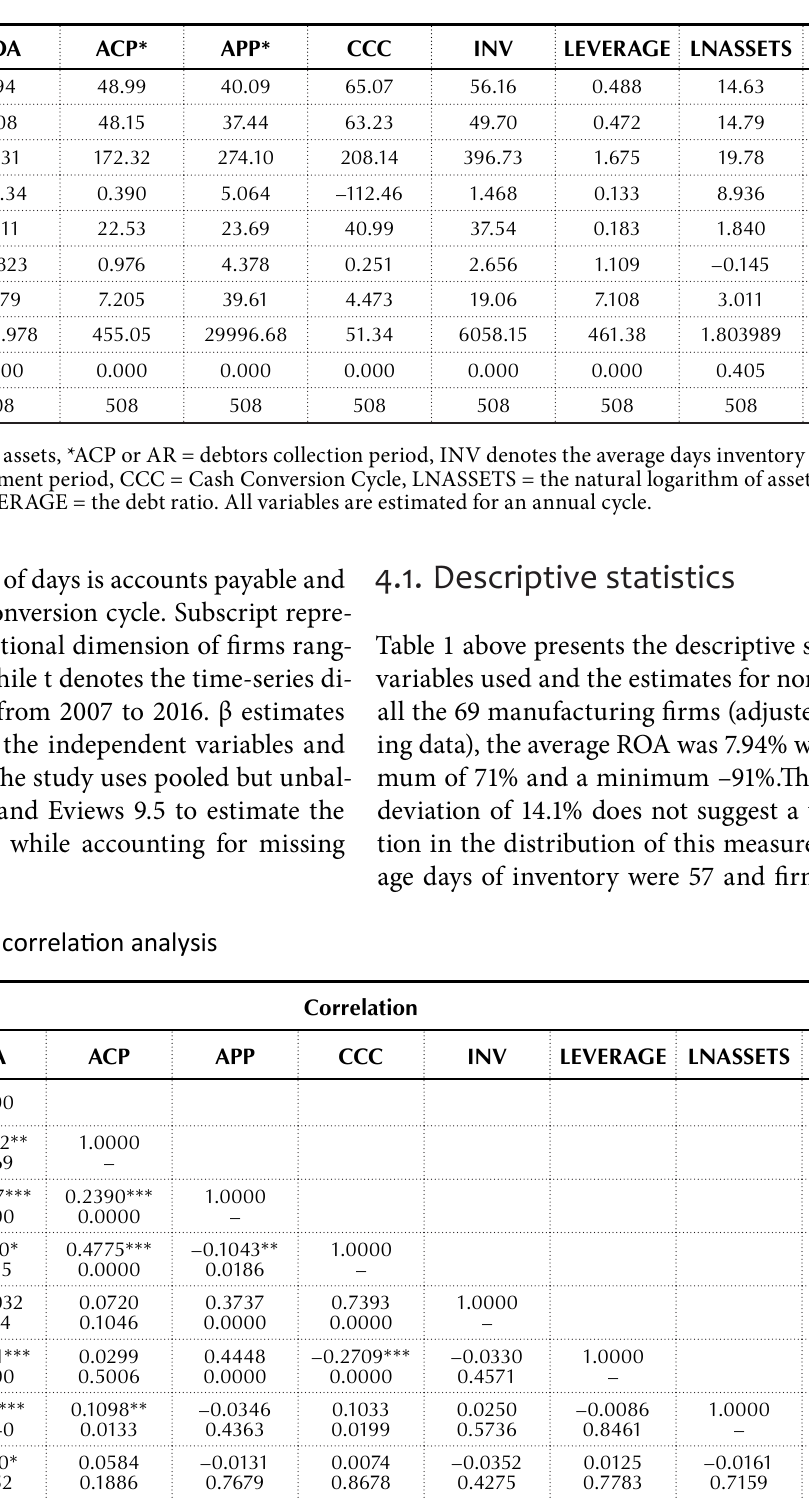
Table 1. Descriptive results of all variables over the 10-year period